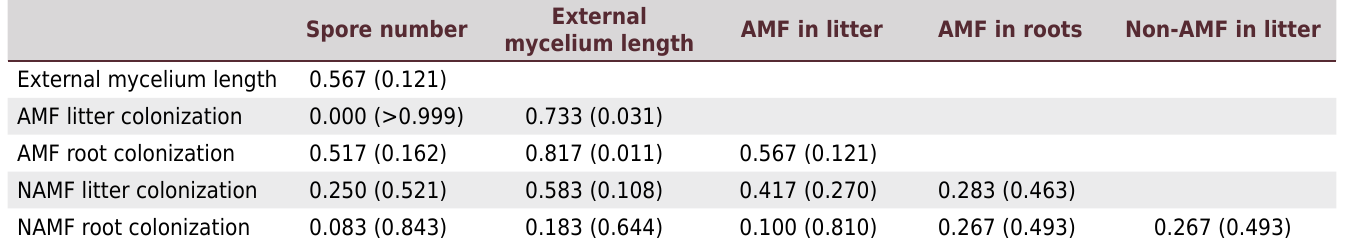
Table 5. Correlations among fungal variables. Spearman coefficient (p-value)